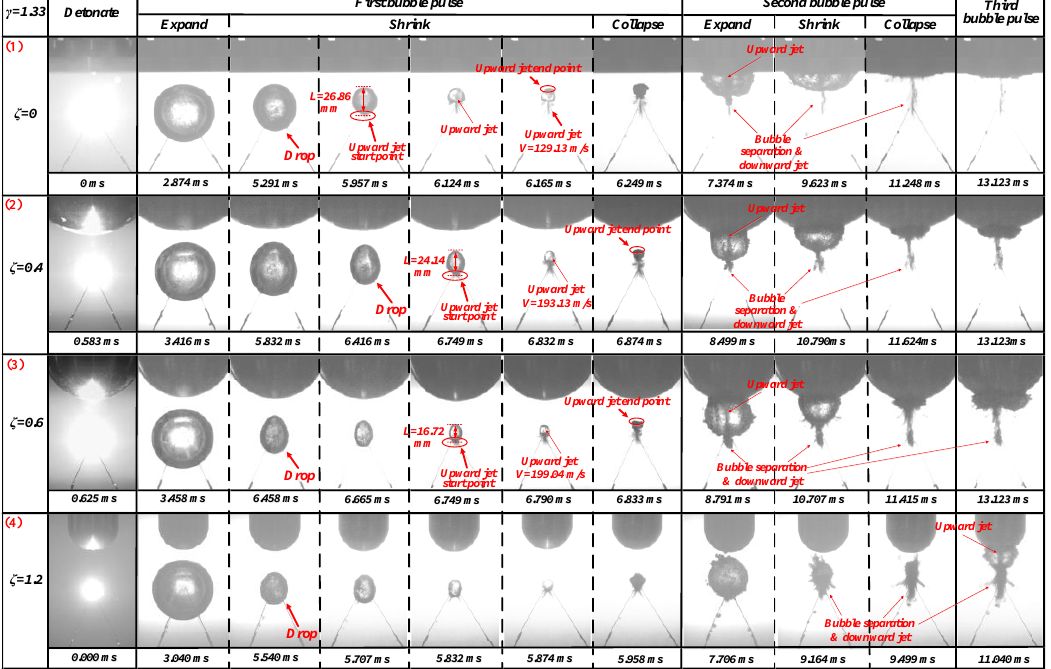
Figure 12. Bubble’s morphological changes under the influence of di ff erent ζ values. The first row shows the bubble’s morphological changes when ζ = 0 and γ = 1.33. The second row shows the bubble’s morphological changes when ζ = 0.4 and γ = 1.33. The third row shows the bubble’s morphological changes when ζ = 0.6 and γ = 1.33. The fourth row shows the bubble’s morphological changes when ζ = 1.2 and γ = 1.33.